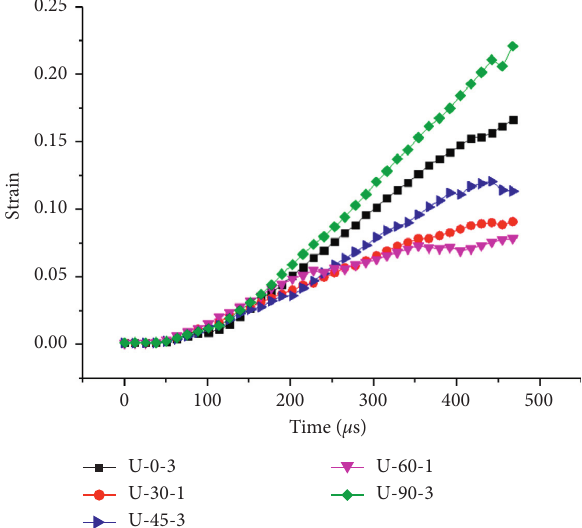
Figure 10: Average strain-time curves of the main failure zones of five typical